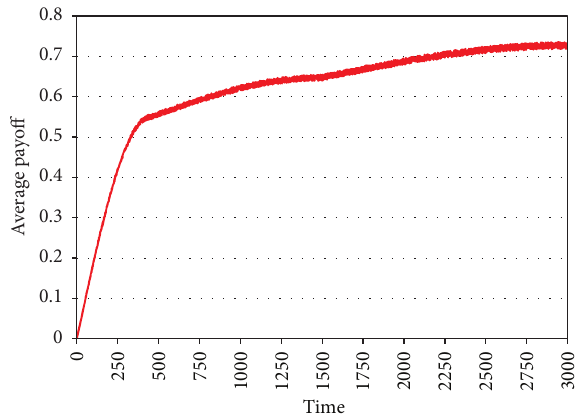
Figure 7: Degree distribution of the proposed complex network.